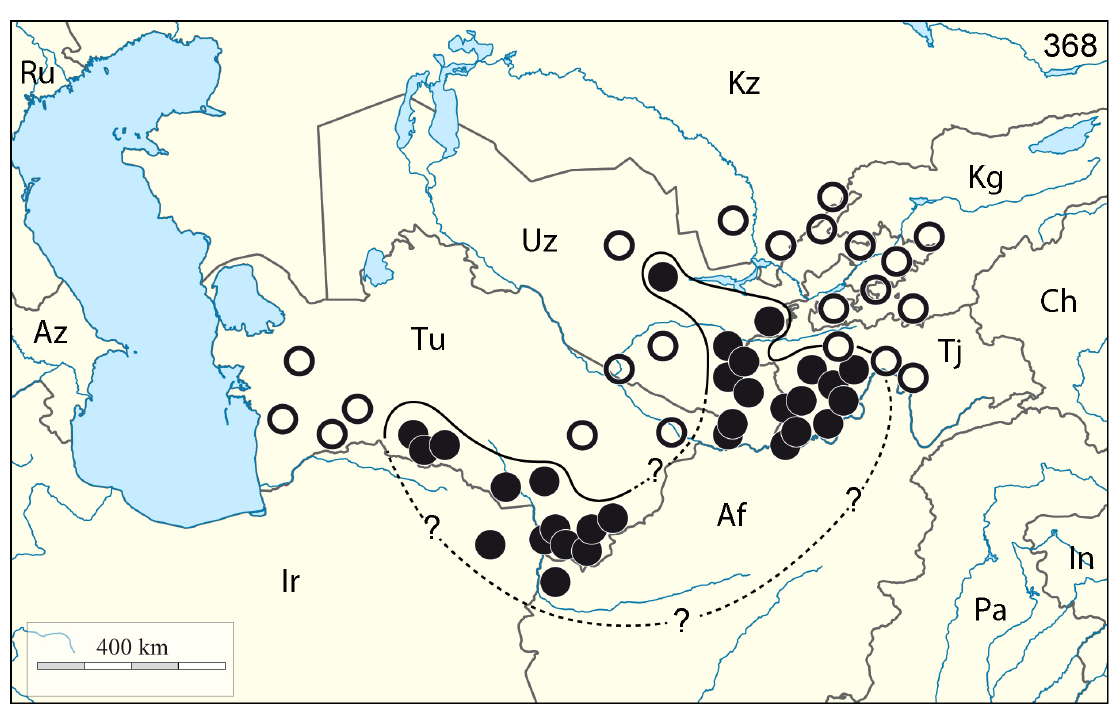
Fig. 368. Suggested range of Anemesia . Records of Anemesia spp. ( ) and intensively sampled localities without those records ( ). Range boundaries: relatively veracious ( — ) and assumed (--?--). Country abbreviations: Af = Afghanistan; Az = Azerbaijan; Ch = China; In = India; Ir = Iran; Kg = Kyrgyzstan; Kz = Kazakhstan; Pa = Pakistan; Ru = Russia; Tj = Tajikistan; Tu = Turkmenistan; Uz = Uzbekistan.